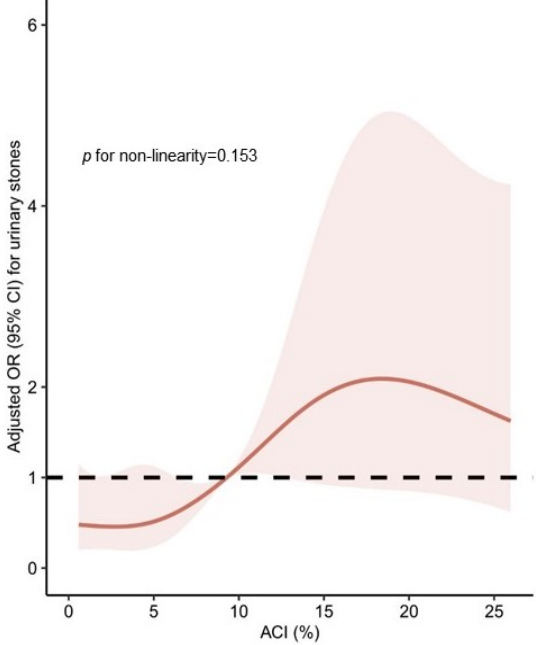
Figure 3. Dose–response relationship between aortic calcification index (ACI) and urinary stones. Association was obtained through restricted cubic splines analyses adjusted for CHD, triglycerides, glucose, serum creatinine, uric acid, urea, calcium, and eGFR. Refer ‐ ence values of ACI = 9.29%. The solid lines and shaded areas represent the OR and corre ‐ sponding 95% CI.